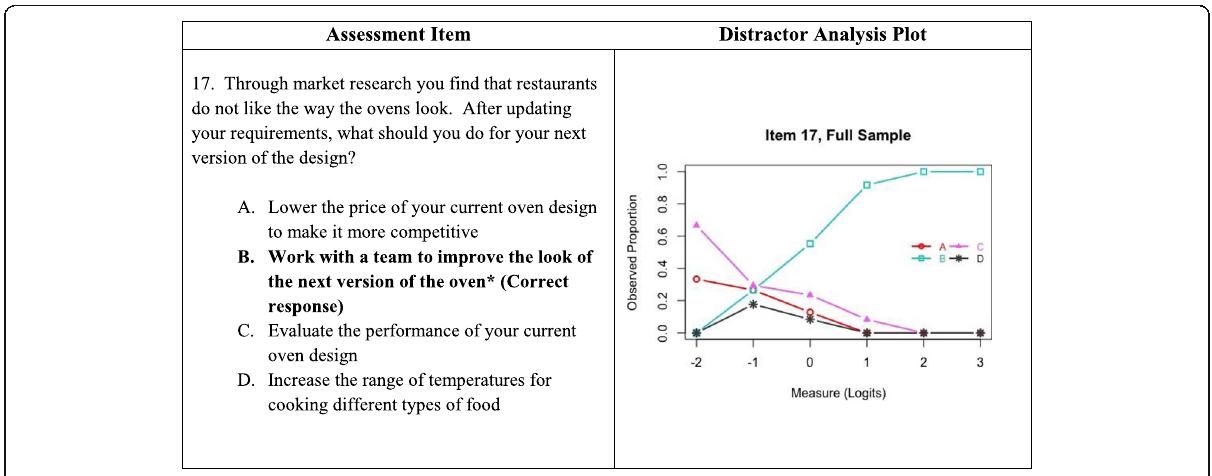
Fig. 5 Distractor analysis plot for item 17: full sample. The plot shows patterns of student answer choices for item 5 within the entire sample. The x -axis displays estimates of student achievement. Student achievement estimates are shown in logits, and these estimates were calculated using the Rasch model. Low values indicate lower achievement, and high values indicate higher achievement. The y -axis shows the observed proportion of responses for a given answer choice. The lines in the plot show the proportion of students who selected each of the four answer choices (A, B, C, or D) at each level of achievement. For this item, the correct response is B (turquoise line with square plotting